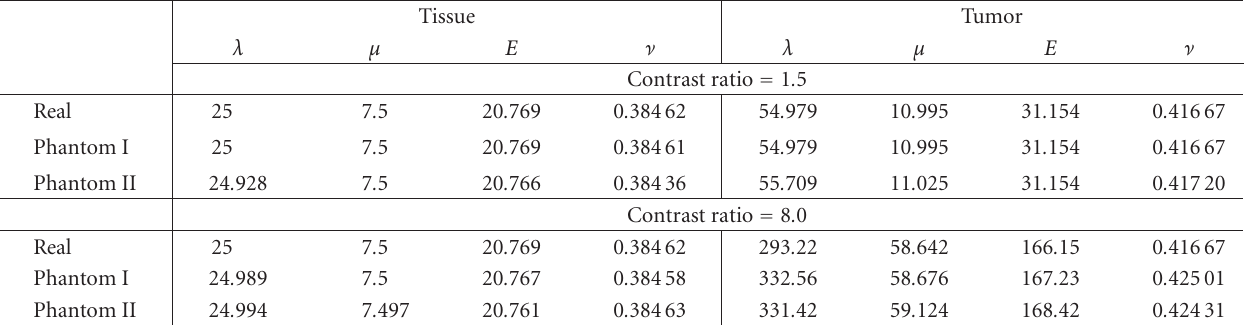
Table 2: Elasto-mammography simulation using phantoms with di ff erent sti ff ness contrast ratios. Tissue